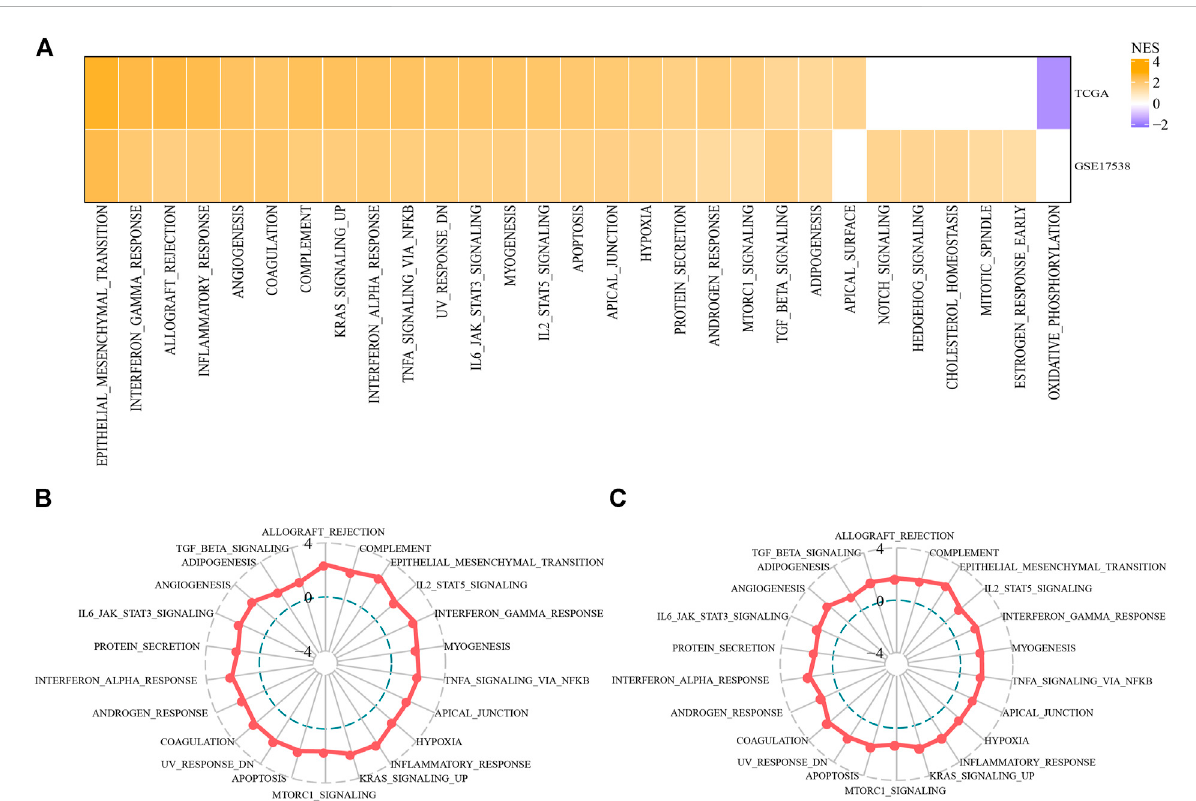
FIGURE 4 Differentially enriched pathways between C1 and C2 subtypes (A) Activated hallmark pathways by comparing C2 with C1 based on normalized enrichment score (NES). Orange indicates upregulated pathways in C2 and purple indicates the reverse (B – C) Rader plots of activated pathways